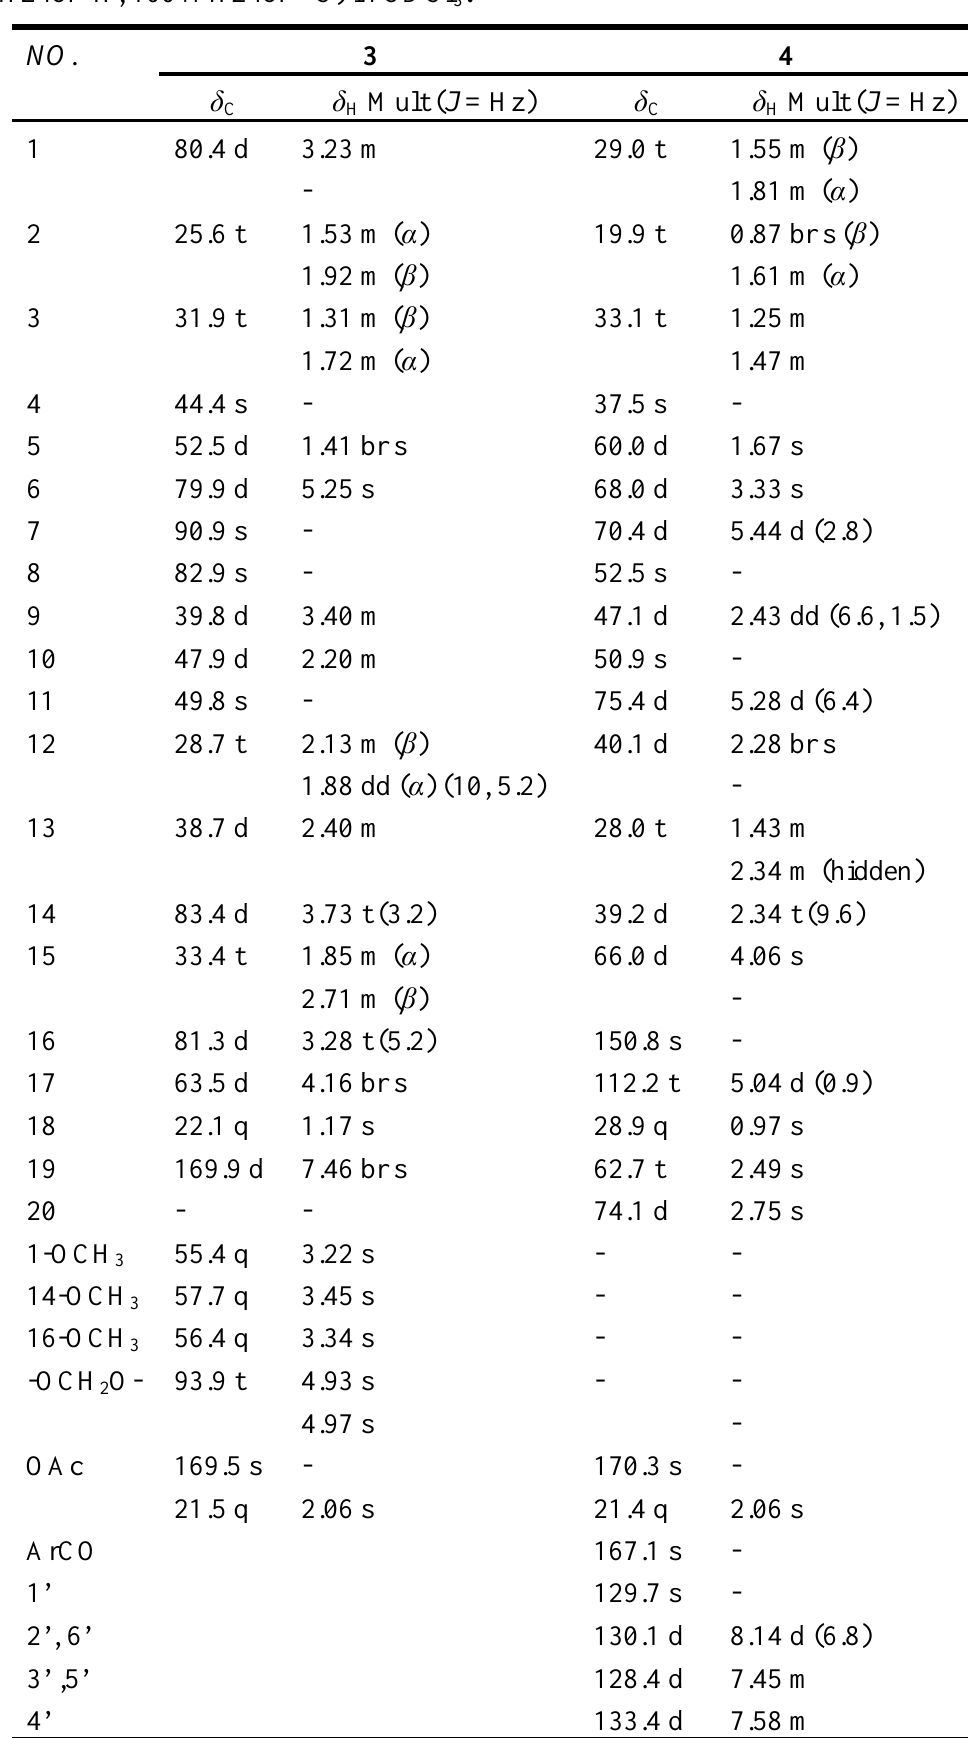
Table 2. NMR data of compounds 3 (600 MHz for 1 H, 150 MHz for 13 C) and 4 (400 MHz for 1 H, 100 MHz for 13 C) in CDCl 3